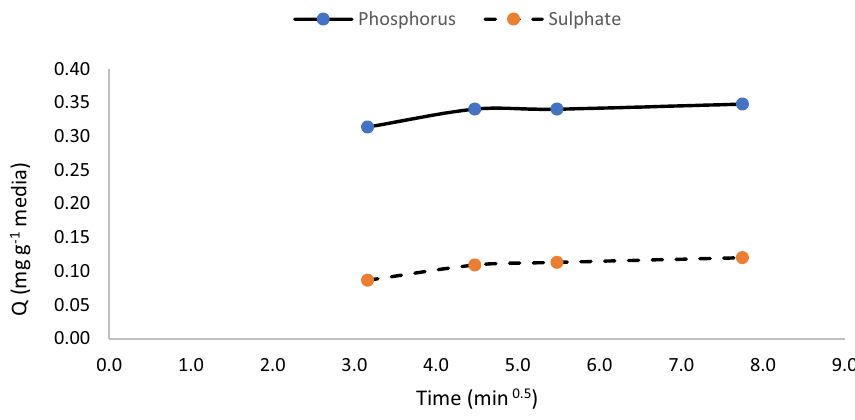
Fig. 6 Intraparticle diffusion graph of PO 43− P and SO 42− adsorption onto acid washed copper smelter slag